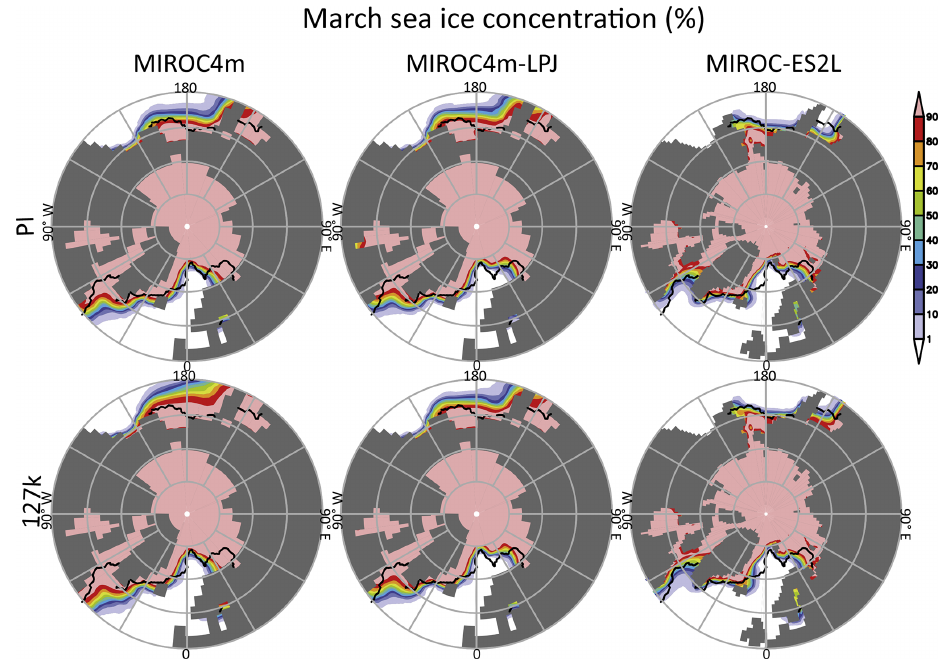
Figure 10. The NH March sea ice concentration (%) in PI and 127k, along with the difference between 127k and PI, is shown for three models. Thick lines indicate a concentration of 15% in the climatology (the HadISST data averaged over 1870–1919). The calendar for 127k is adjusted using a method based on Bartlein and Shafer (2019).